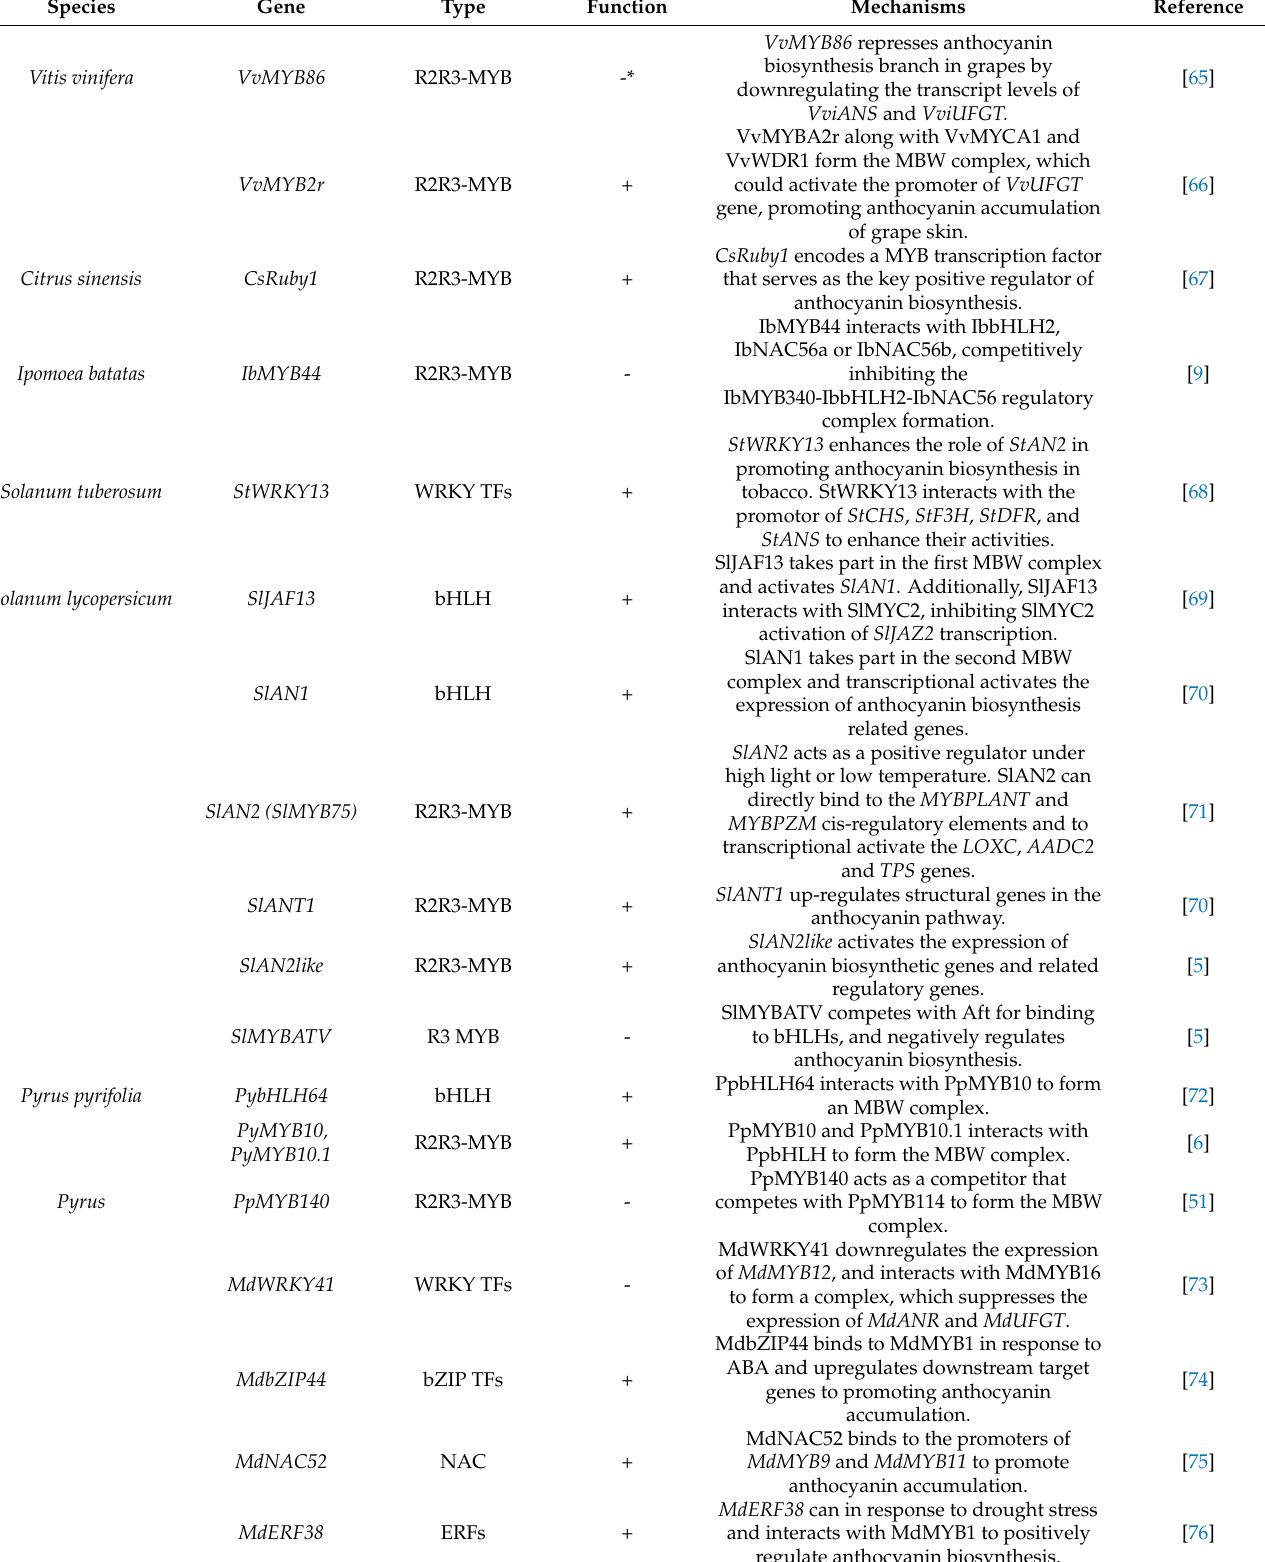
Table 2. Transcription factors involved in anthocyanin